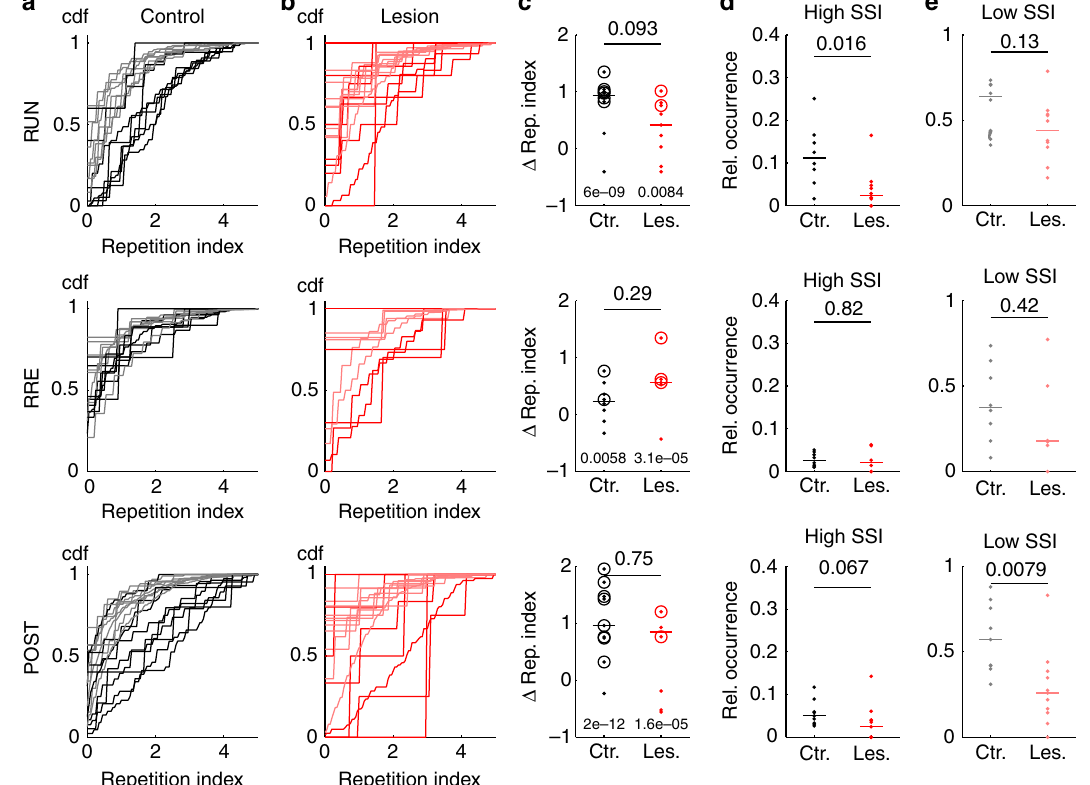
Fig. 3 Spatial sequences recurred more frequently than nonspatial sequence motifs. a CDFs of repetition indices for spatial (signi fi cant SSI from Fig. 2b, c; black) and signi fi cant sequence motifs with low SSI (gray) in control animals for epoch types (RUN: n control = 7 epochs; PRE: n control = 7 epochs; POST: n = 9 epochs) as indicated. Each CDF is derived from one epoch. b Same as in ( a ) for MEC-lesioned animals (red: signi fi cant SSI, pink: nonsigni fi cant control SSI; RUN: n lesion = 9 epochs; PRE: n lesion = 5 epochs; POST: n lesion = 8 epochs). c Difference of medians between high- and low-SSI CDFs from ( a ) and ( b ), p values above bar were obtained from ranksum test, RUN: r.s. = 90, PRE: r.s. = 48, POST: r.s. = 85; p values above group labels were obtained from a binomial test on the number of signi fi cant epochs (circles) for a chance level of 5%; RUN: 6 out of 8 epochs were signi fi cant in control animals, 2 out of 9 epochs were signi fi cant in MEC-lesioned animals; PRE: 2 out of 8 epochs were signi fi cant in control animals, 3 out of 5 epochs were signi fi cant in MEC- lesioned animals; POST: 8 out of 9 epochs were signi fi cant in control animals, 4 out of 8 epochs were signi fi cant in MEC-lesioned animals; colors as in ( a ) and ( b ). d Relative (Rel.) occurrence computed as the fraction of spatially signi fi cant sequences among all bursts ( p value obtained from ranksum